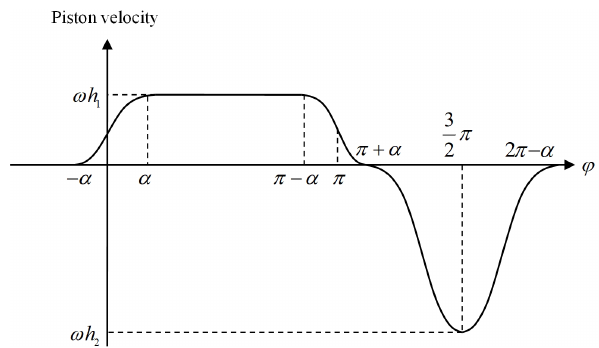
Figure 5. Piston velocity of the two-piston